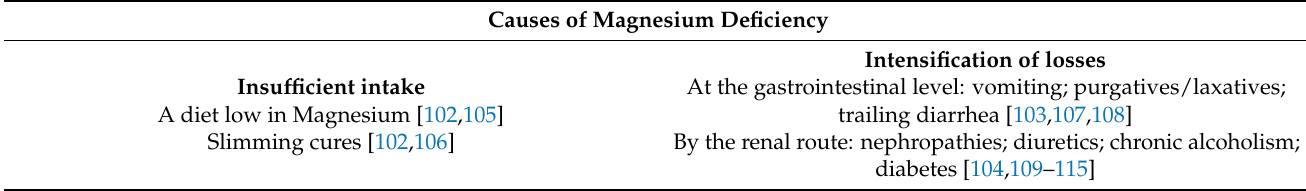
Table 2. Causes of magnesium